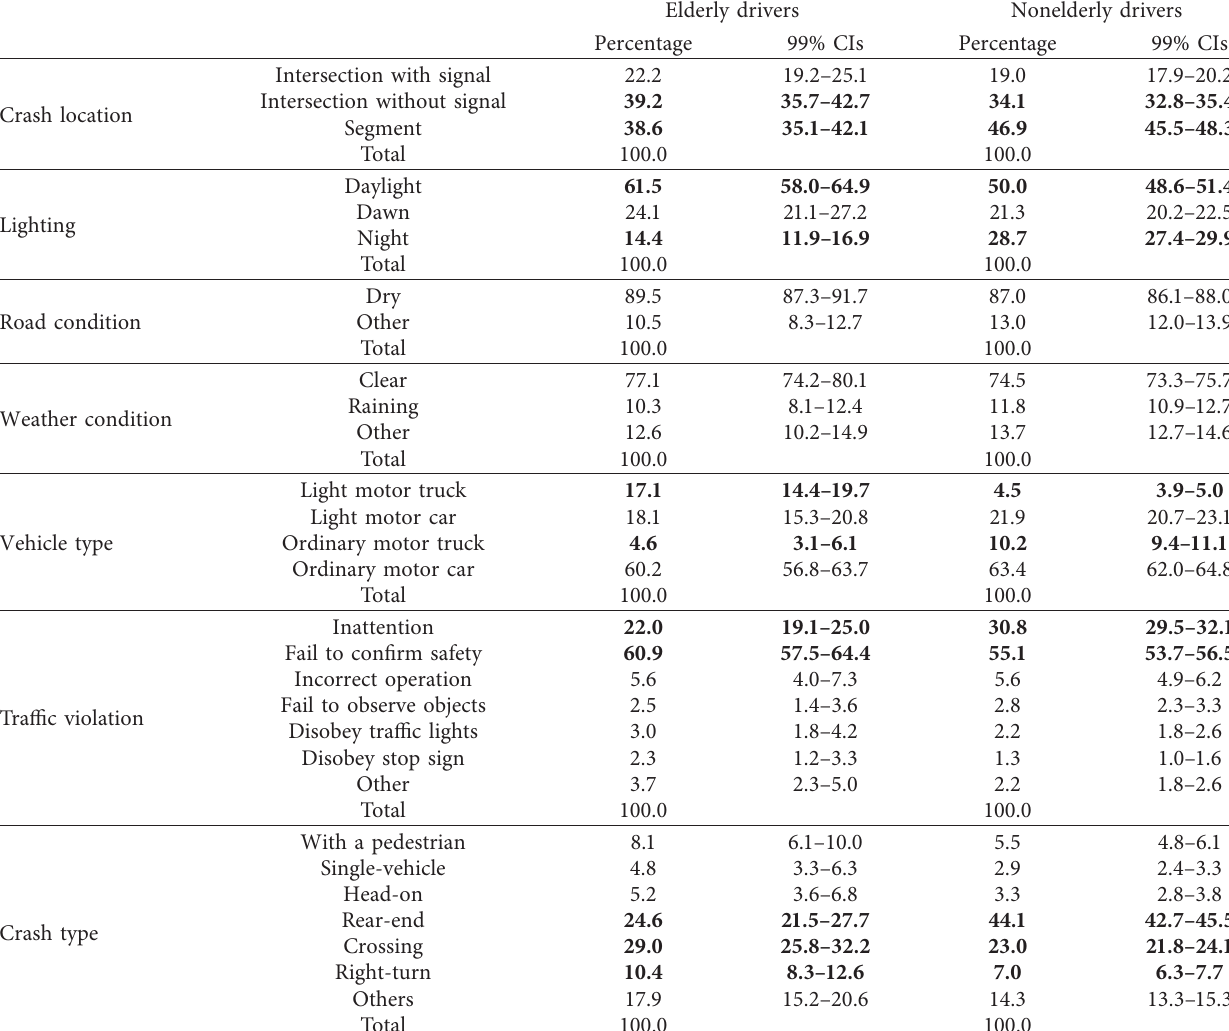
Table 1: Descriptive statistics of significant